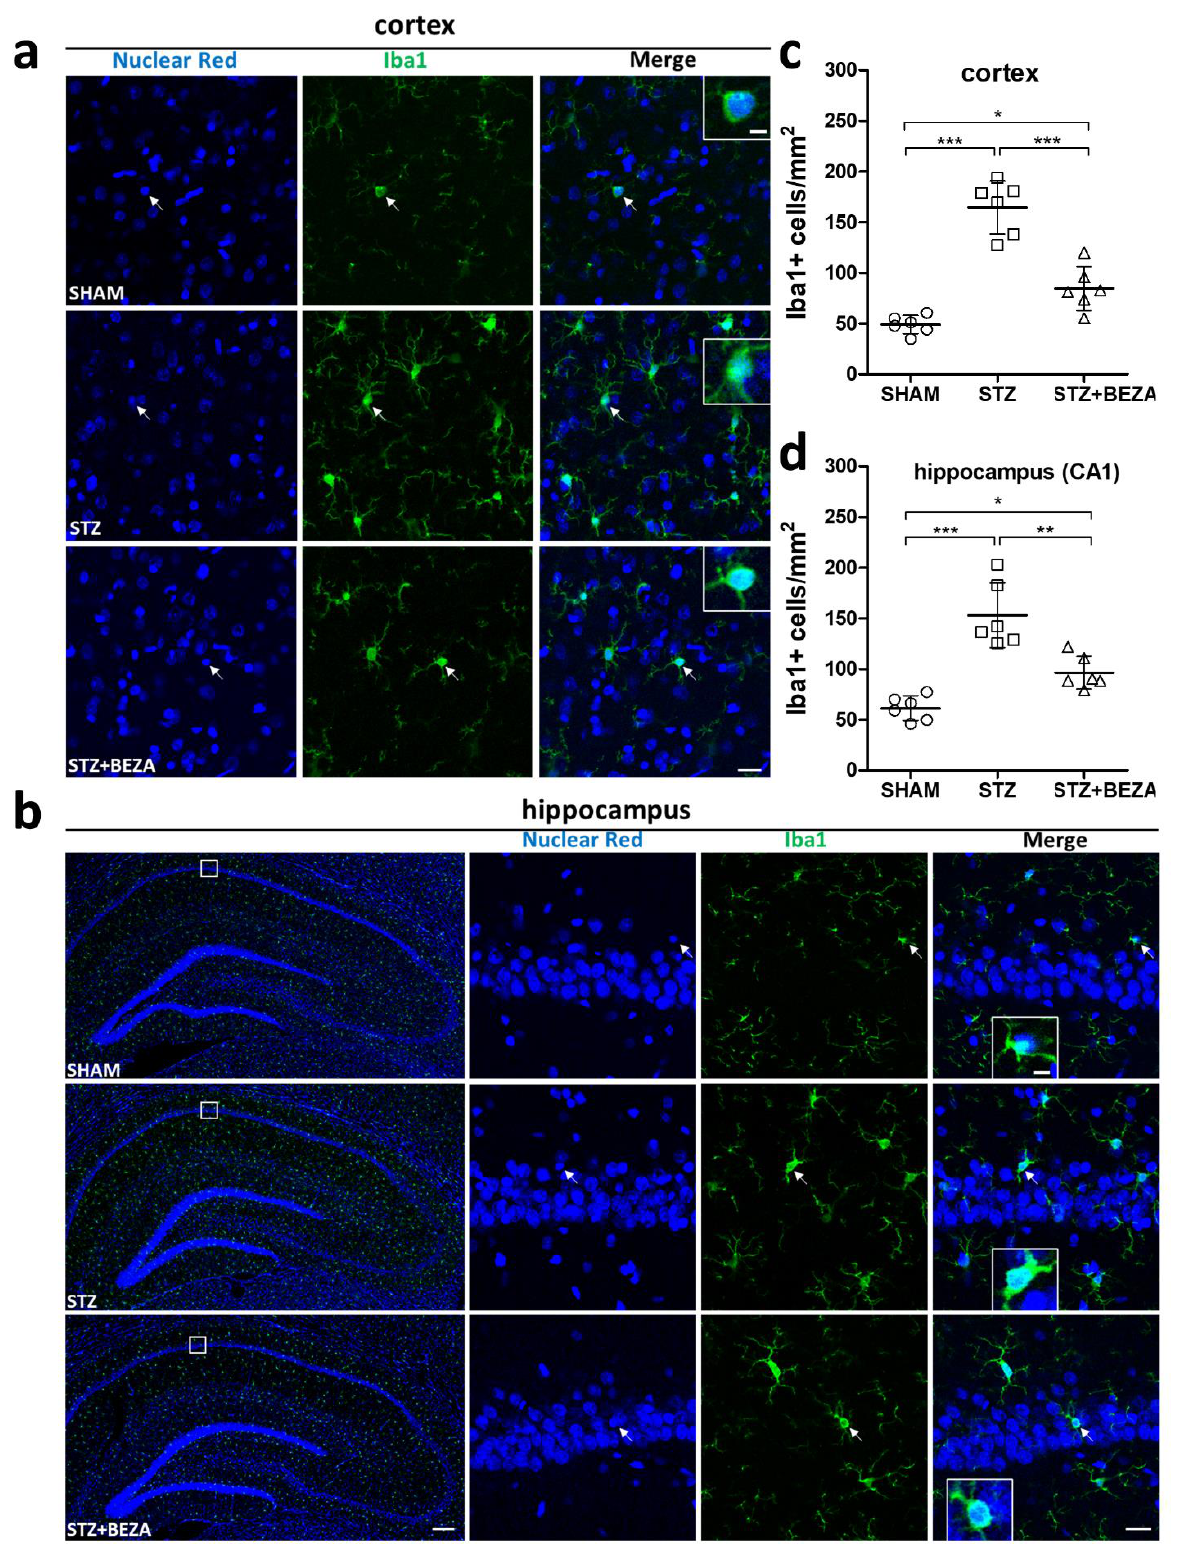
Figure 6. Bezafibrate reduced microgliosis in STZ-ICV-injected rats. Microgliosis was evaluated by immunofluorescence staining with anti-Iba1 antibody (green, for microglia) and nuclear red (blue, as nuclear counterstain). Iba1-staining positive cells were significantly increased in the cortex ( a ) and hippocampus ( b ) of the STZ group (middle rows), compared to those in the SHAM group (upper